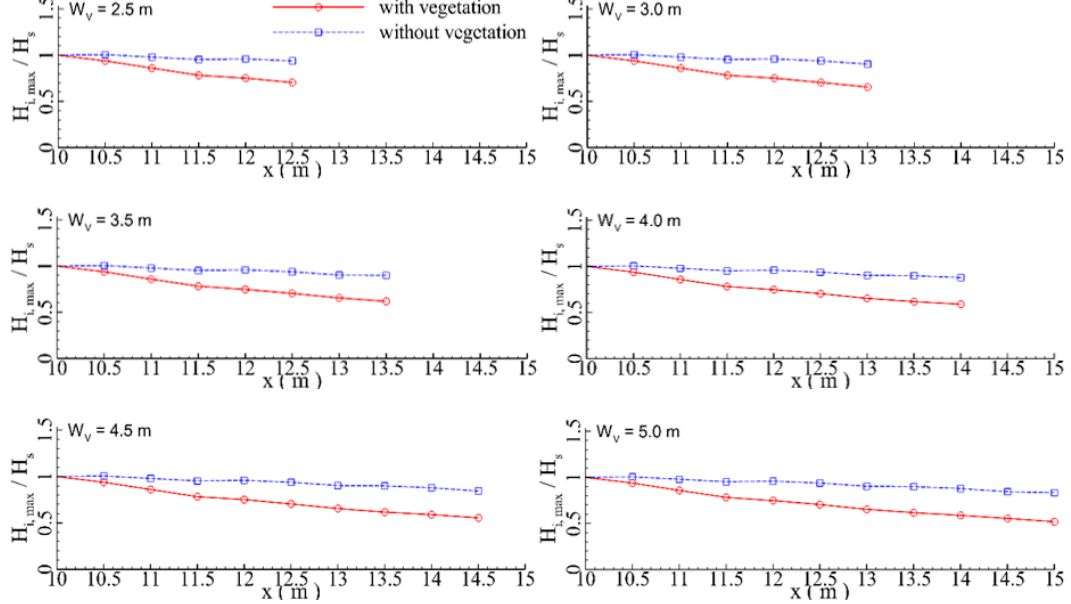
Figure 30. Spatial distributions of the local maximum wave height under different vegetation lengths.